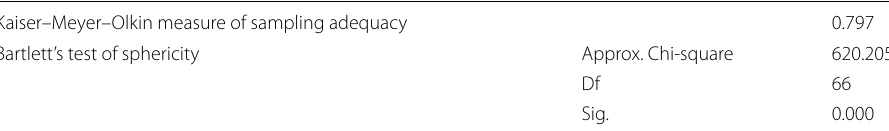
Table 6 KMO and Bartlett’s test (Pre-DeMo, Anand) Kaiser–Meyer–Olkin measure of sampling adequacy